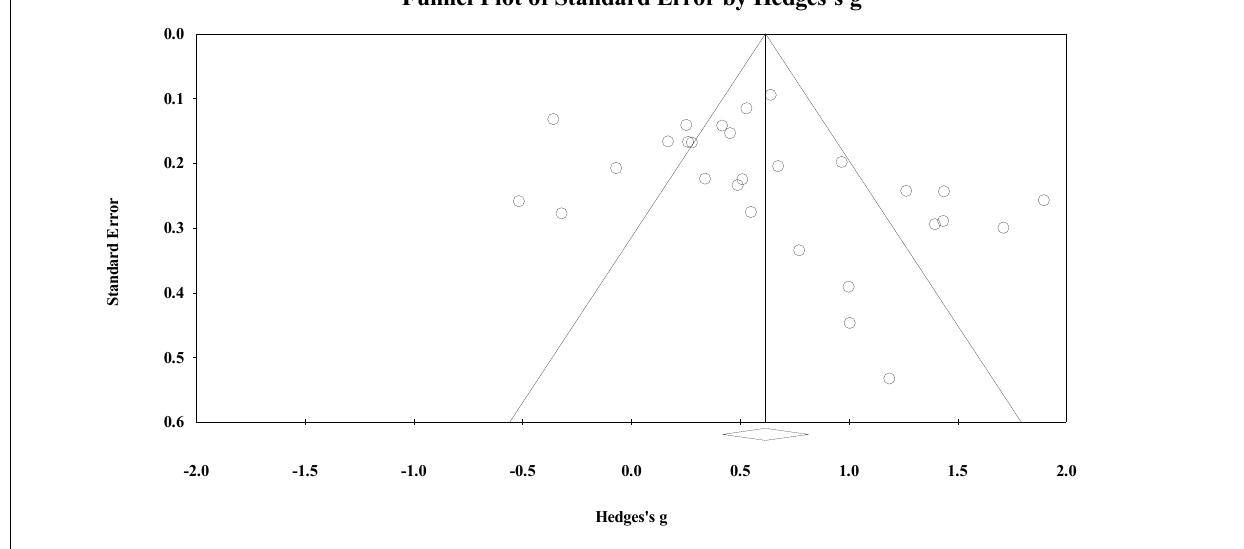
Figure 3. Funnel plot: All studies.